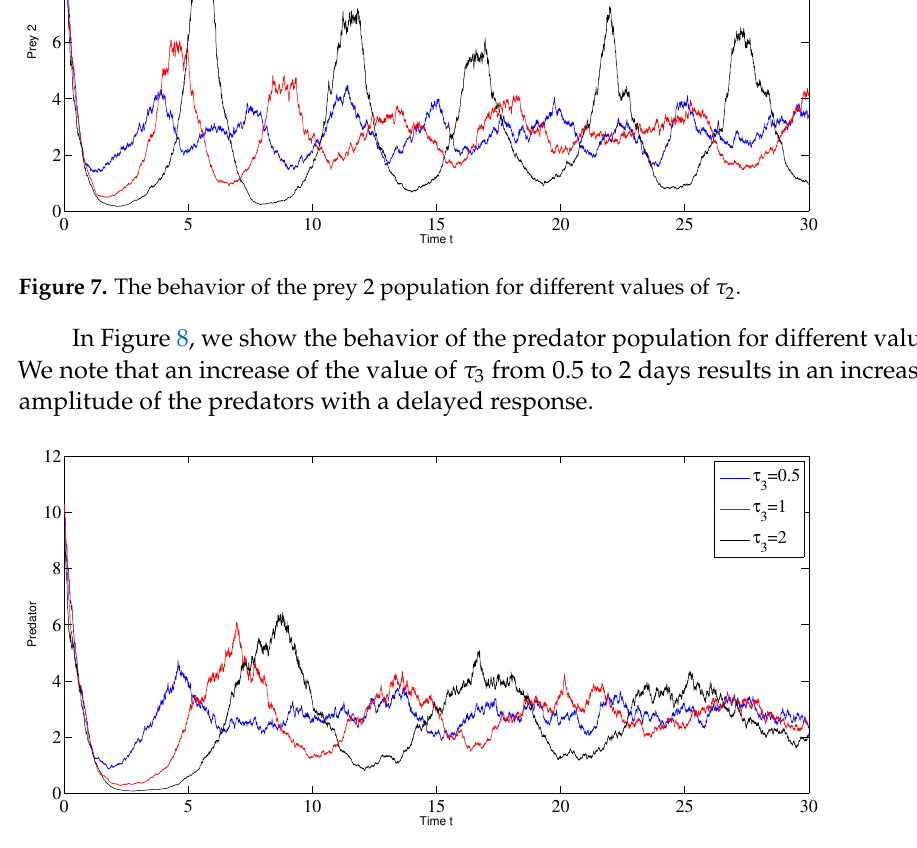
Figure 8. The behavior of the predator population for different values of τ 3